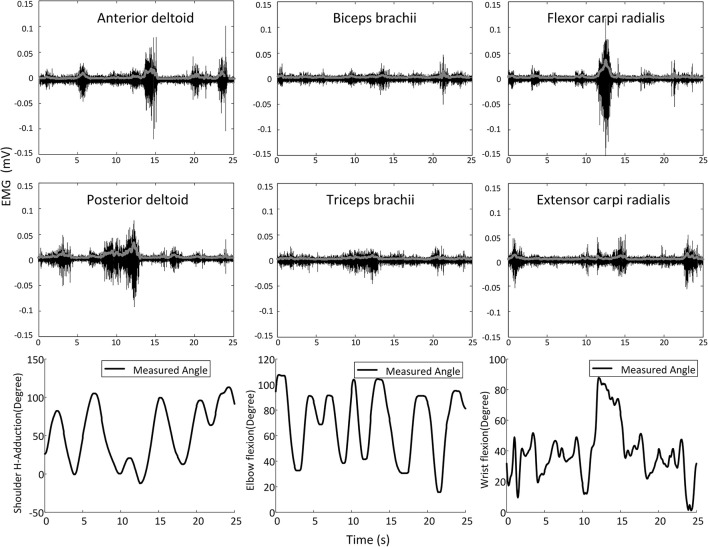
Representative shoulder, elbow, and wrist movements and the corresponding surface EMG signals (raw signals are in black and the corresponding linear envelope profiles are in gray) recorded in a movement trial on one subject.